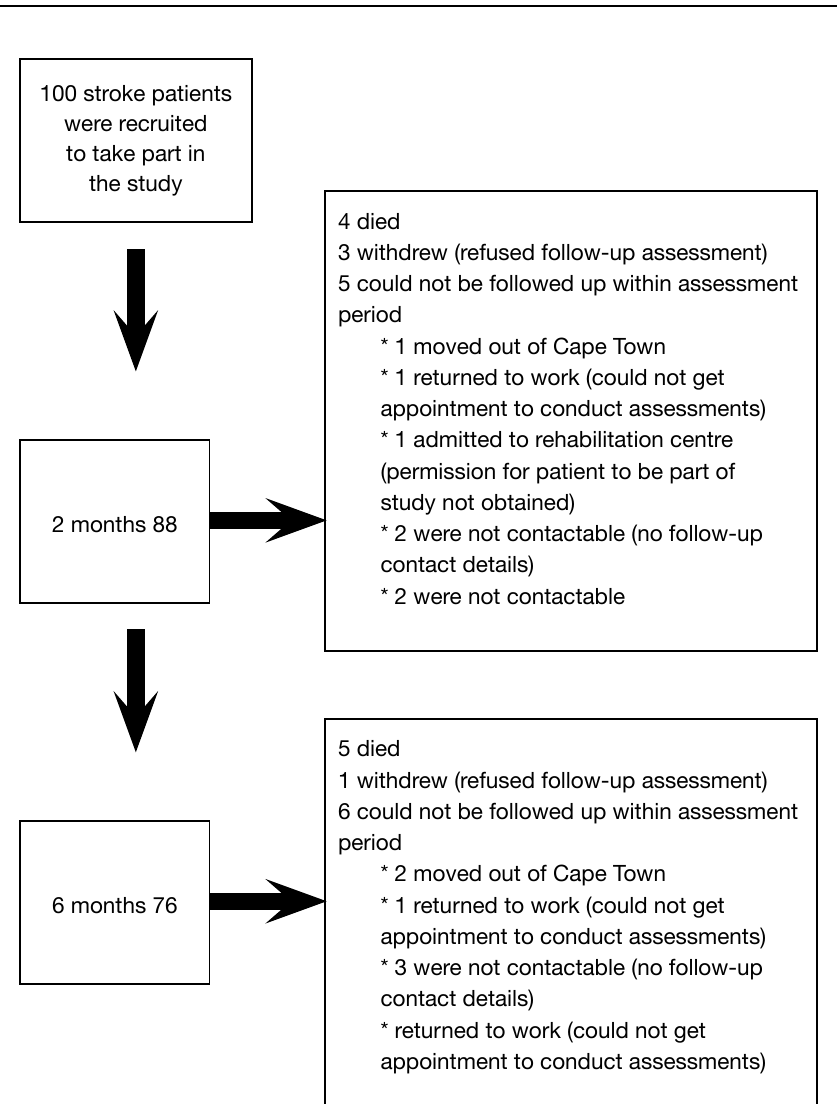
Figure 1: Results of participant recruitment